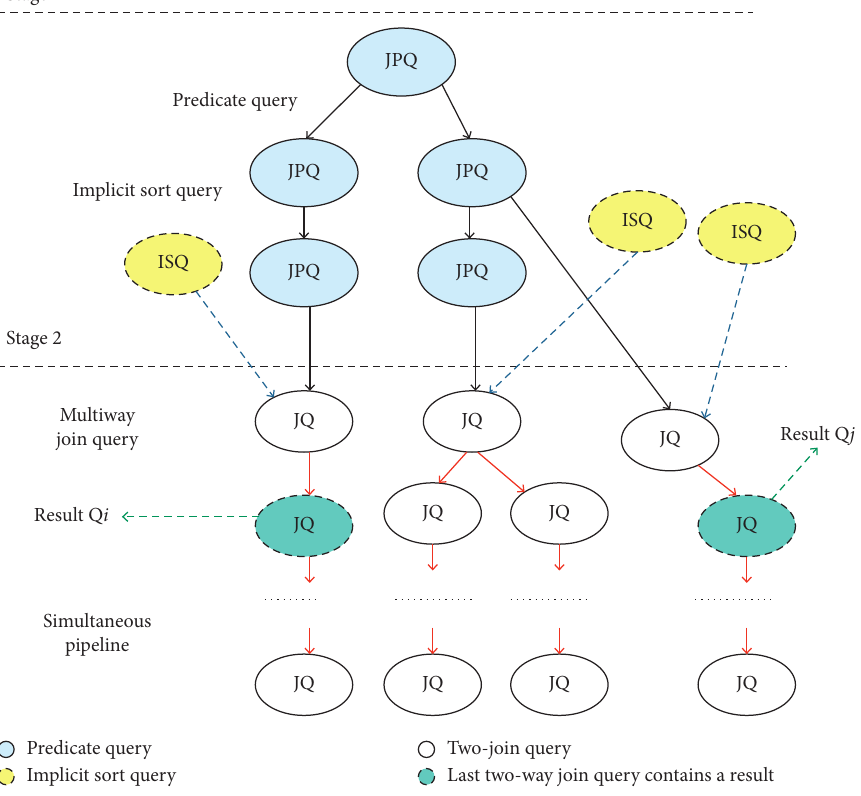
Figure 14: The J-MOTH multiway join optimized plan. Table 4: The J-Moth Execution Time and Improvement Comparison using Flink Join Strategies.